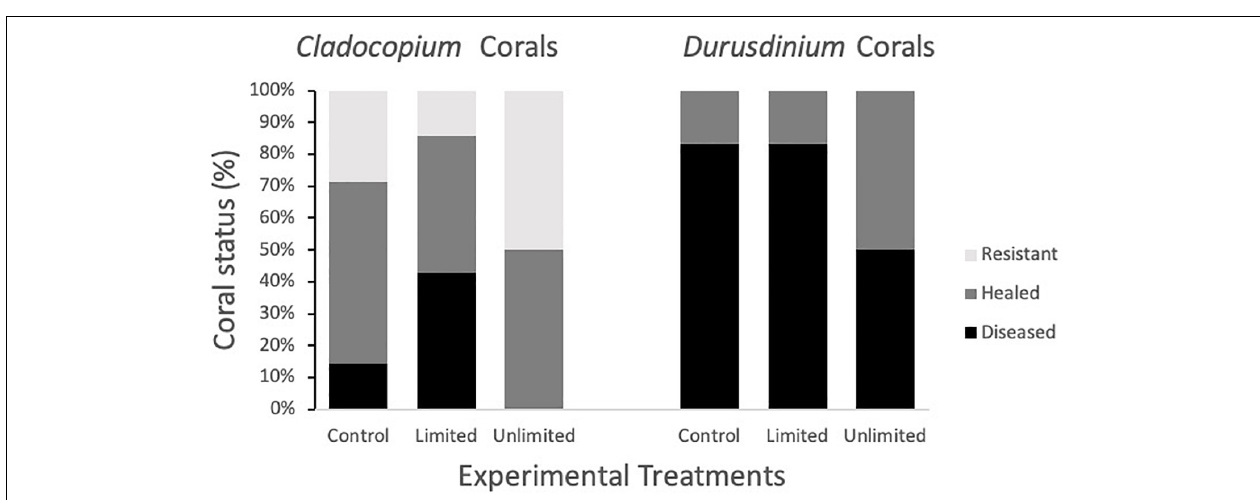
FIGURE 6 | Coral fragment status at the end of the study as a function of experimental treatment (control, limited, unlimited) and presence of Cladocopium spp. vs. Durusdinium .